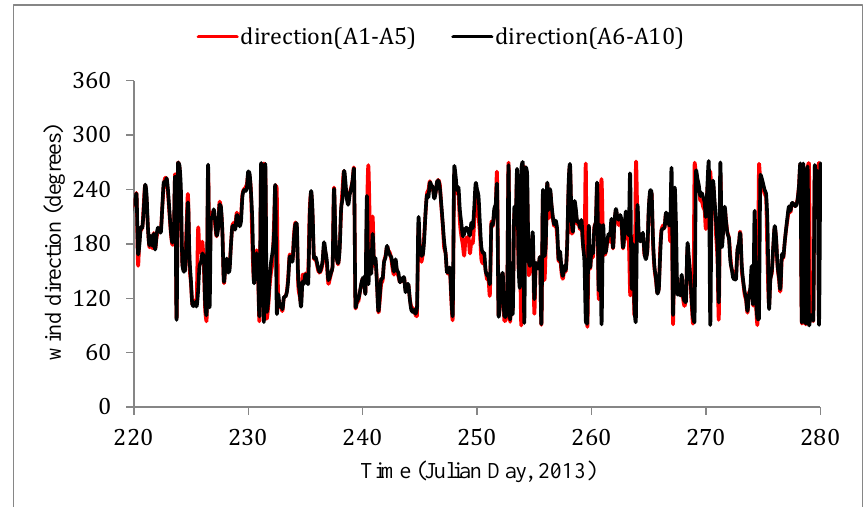
Figure 3. ECMWF wind directions.